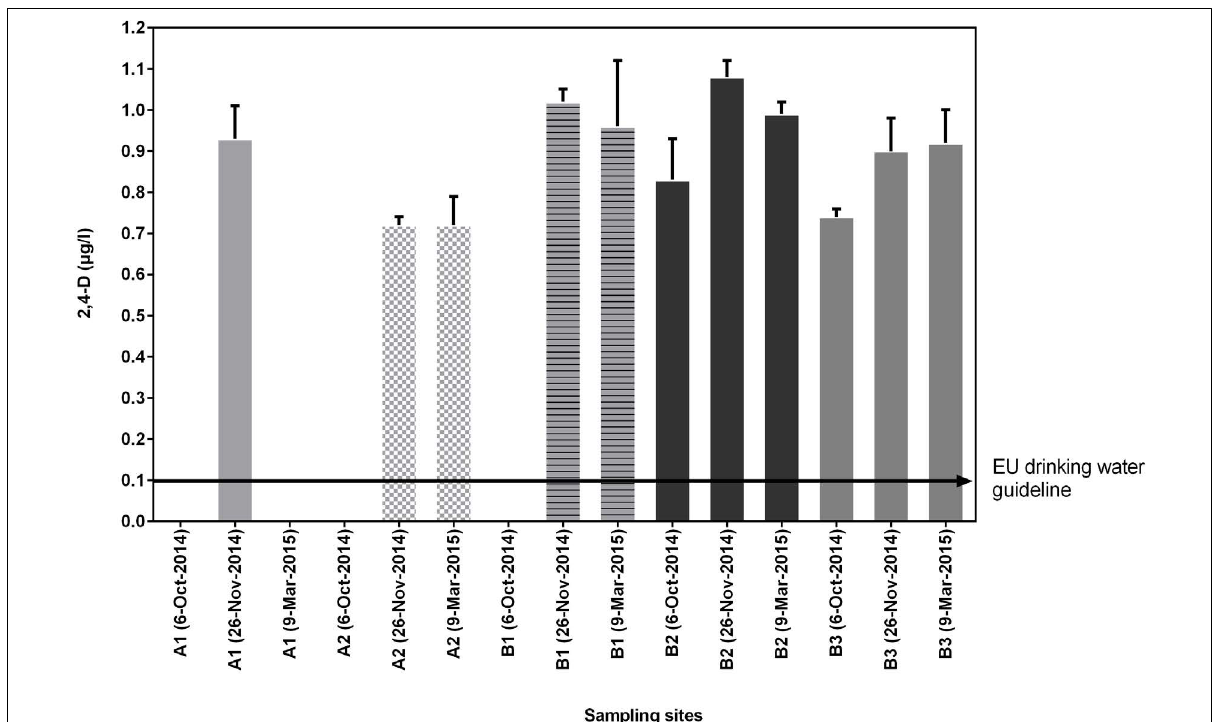
Figure 2: Concentrations of 2,4-D (µg/L) found across all sites and exceedance of the EU drinking water guideline (0.1